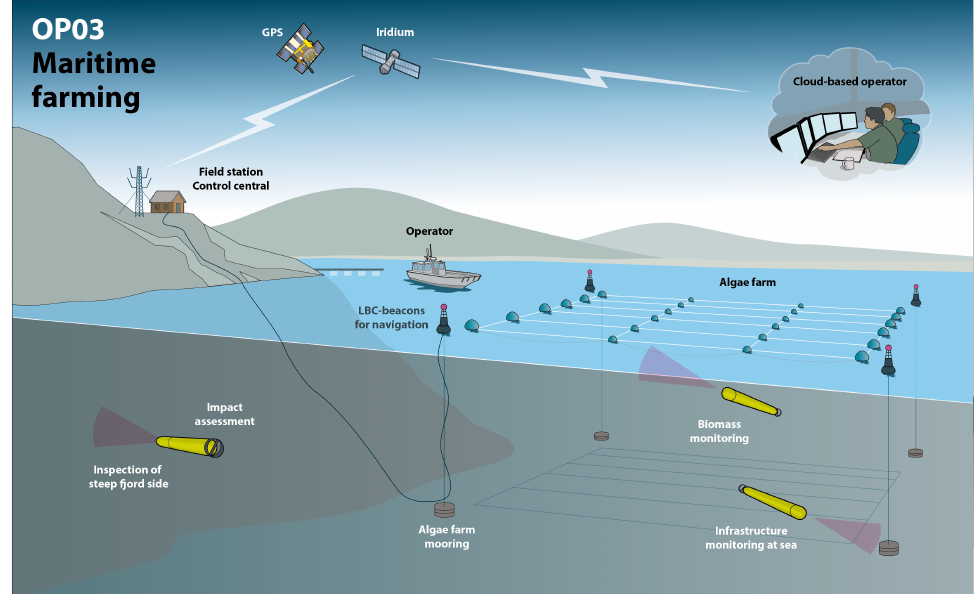
Figure 1. Illustration of scenario with kelp farm and underwater robots (illustration by M.